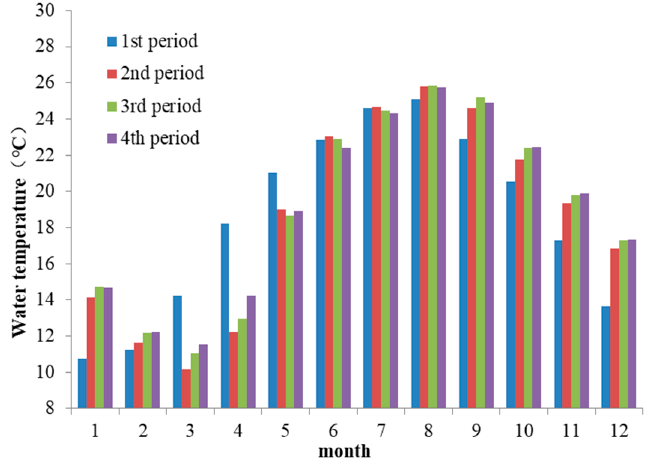
Figure 8. Monthly discharge water temperature of the Three Gorges dam.